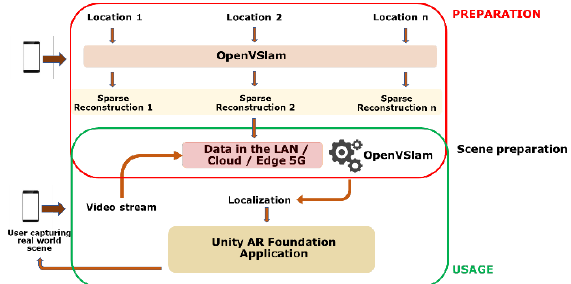
Figure 2 . The proposed methodology. The area is